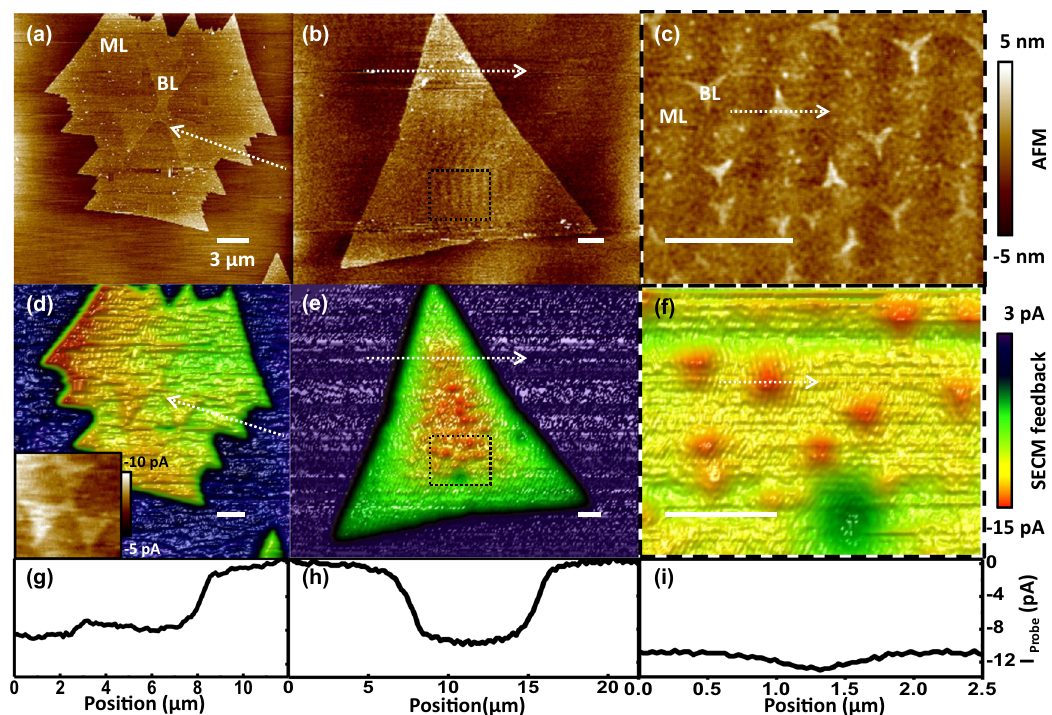
Fig. 3 SECM feedback mapping of monolayer and bilayer MoS 2 . AFM topographs and SECM maps of ( a , d ) three complete pieces of bilayer fl akes ( b , e ) high density of bilayer fl akes on monolayer MoS 2 ( c , f ) give a zoomed scan of the area indicated by a dashed box in b , e . Color and height scales are identical for all images and the white bars indicate a distance of 3 μ m. (Scan rate: 20 µ m/s, V WE-RE (Ag) : 0.6 V, Fc mediator). The inset of d gives a magni fi ed view with adjusted contrast. g – i show SECM cross-sectional pro fi les along the dotted arrows in images d – f